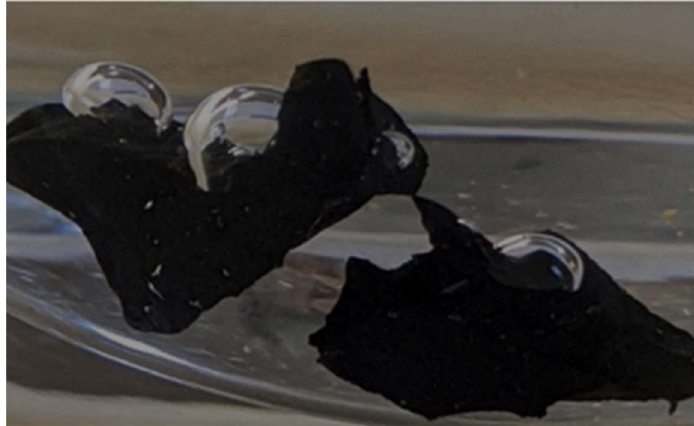
Figure 5. Trapped air bubbles on tire shreds submerged in water [23].